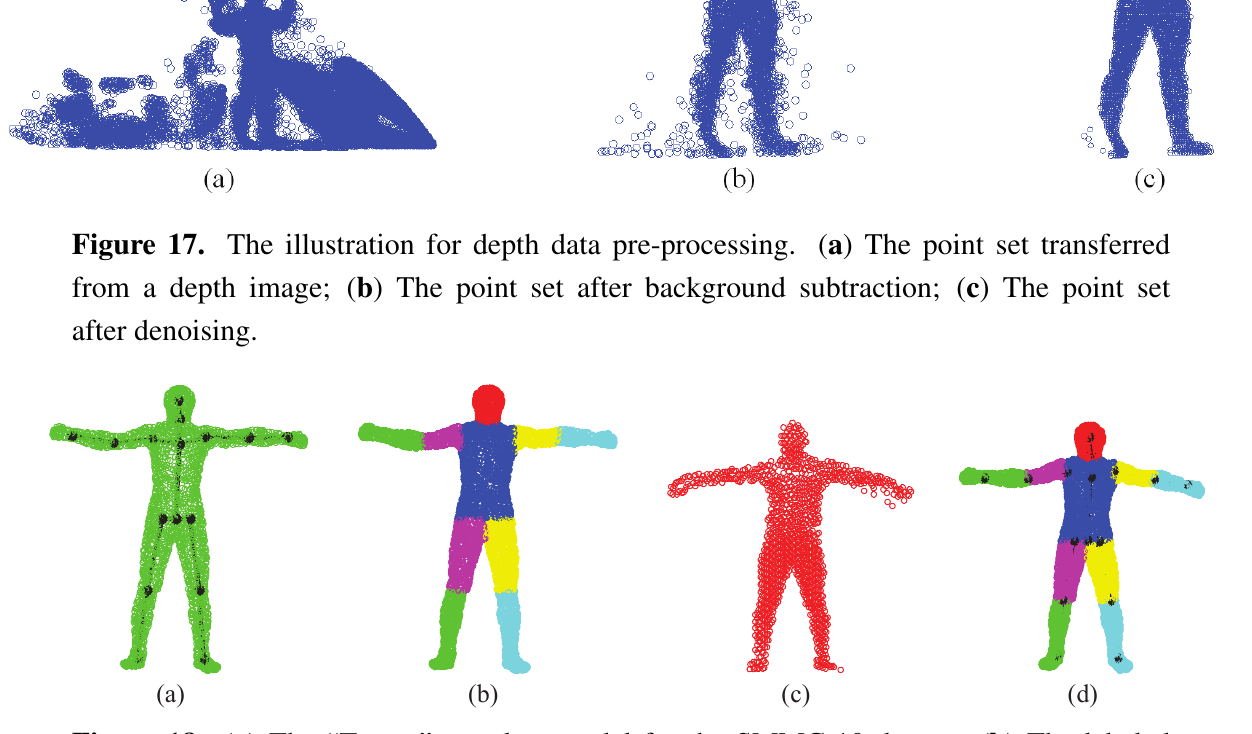
Figure 18. ( a ) The “T-pose” template model for the SMMC-10 dataset; ( b ) The labeled template; ( c ) The initial pose from a depth image; ( d ) The subject-specific articulated model obtained by transforming the template